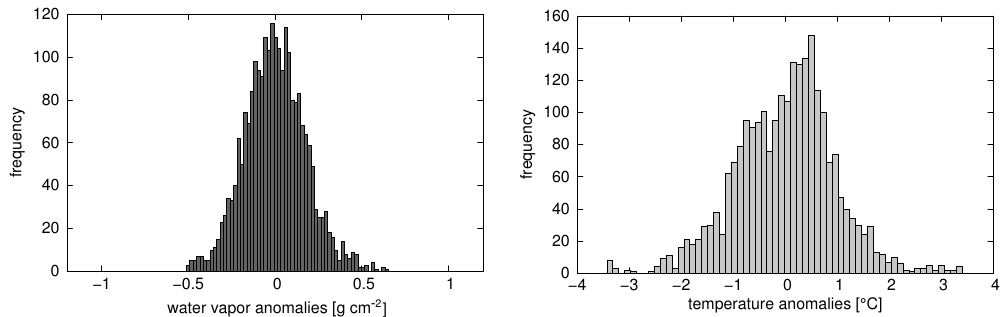
Fig. 3. By removing the trend and the seasonal components from monthly mean temperature and water vapour data we derive the water vapour and temperature anomalies. The frequency distributions of these anomalies for the time span from 1996 to 2005 for the region of the Iberian Peninsula are shown in the above figure. Altogether we gather for each climate parameter 2400 monthly anomalies for the considered region and time span.